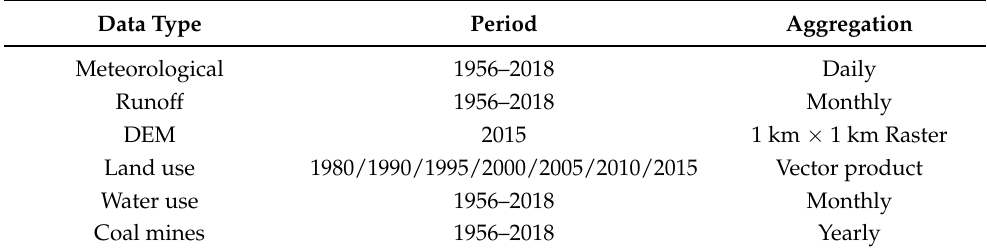
Table 1. Data inputs in model